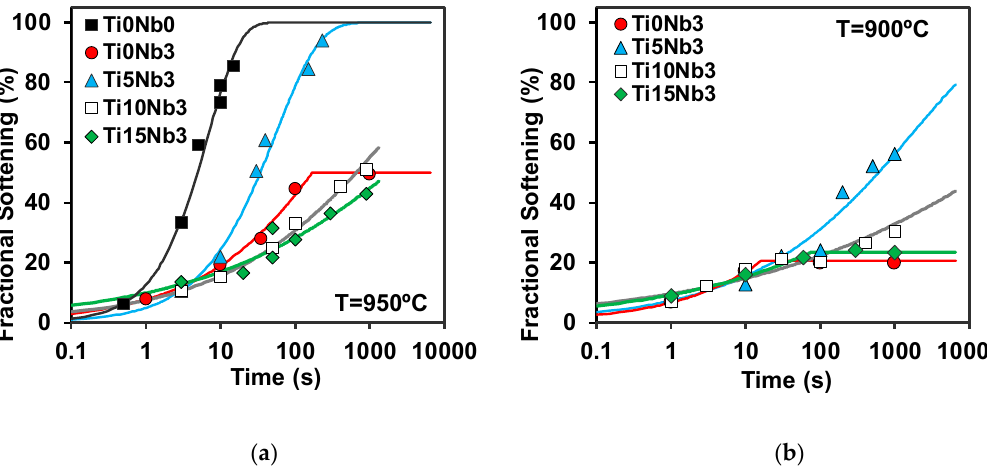
Figure 8. Effect of steel composition on the softening curves at high temperatures, roughing pass applied, 𝜀 = 0.35, 𝜀(cid:4662) = 1 s − 1 . ( a ) T = 1100 °C, ( b ) 1050 °C. Figure 9. Softening kinetics for the steels investigated at low temperatures, roughing pass applied, 𝜀 = 0.35, 𝜀(cid:4662) = 1 s − 1 . ( a ) T = 950 °C, ( b ) 900 °C.